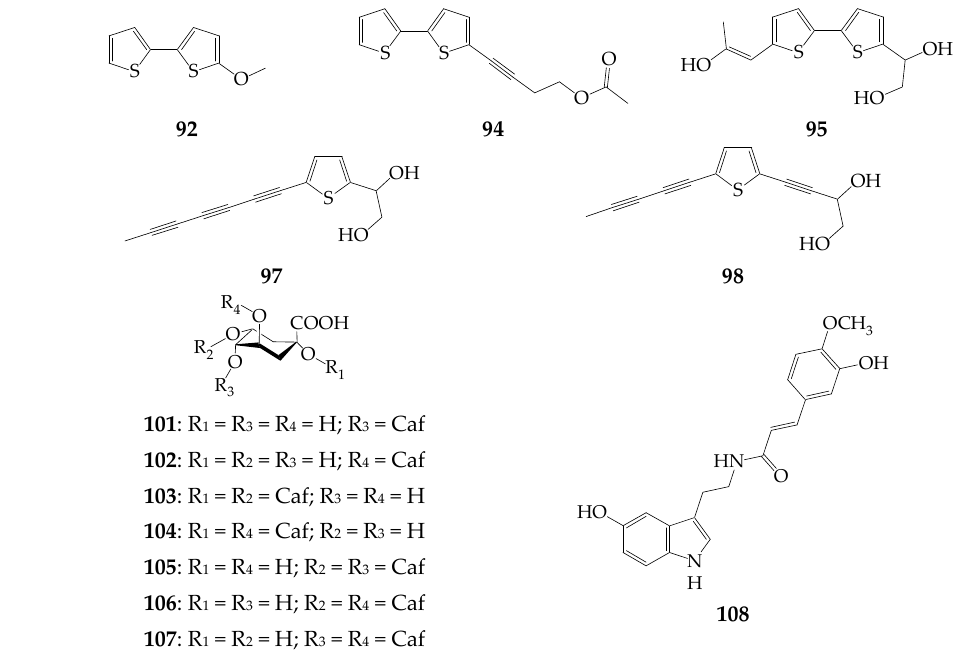
Figure 5 . Thiophenes 87 – 98 and hydroxycinnamates 99 – 108 . Caf–caffeoyl. Figure 5. Thiophenes 87 – 98 and hydroxycinnamates 99 – 108 .